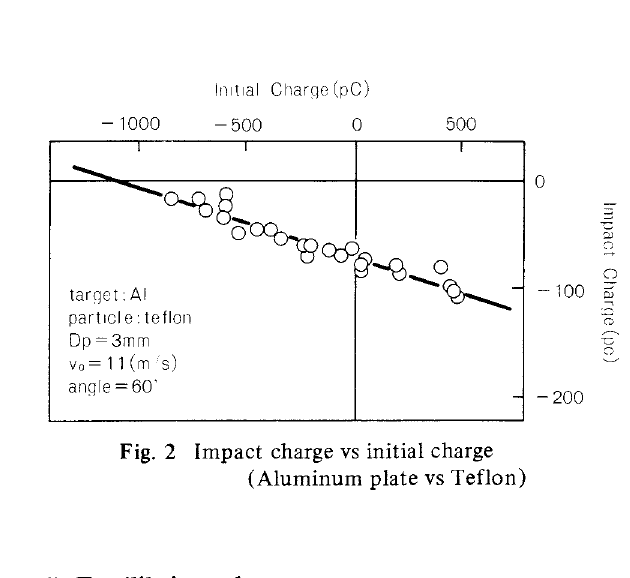
Fig. 2 Impact charge vs initial charge (Aluminum plate vs